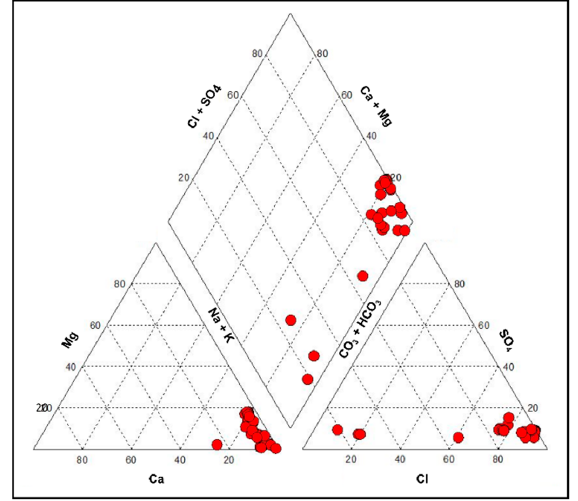
Figure 11. Piper diagram of water samples from wells.